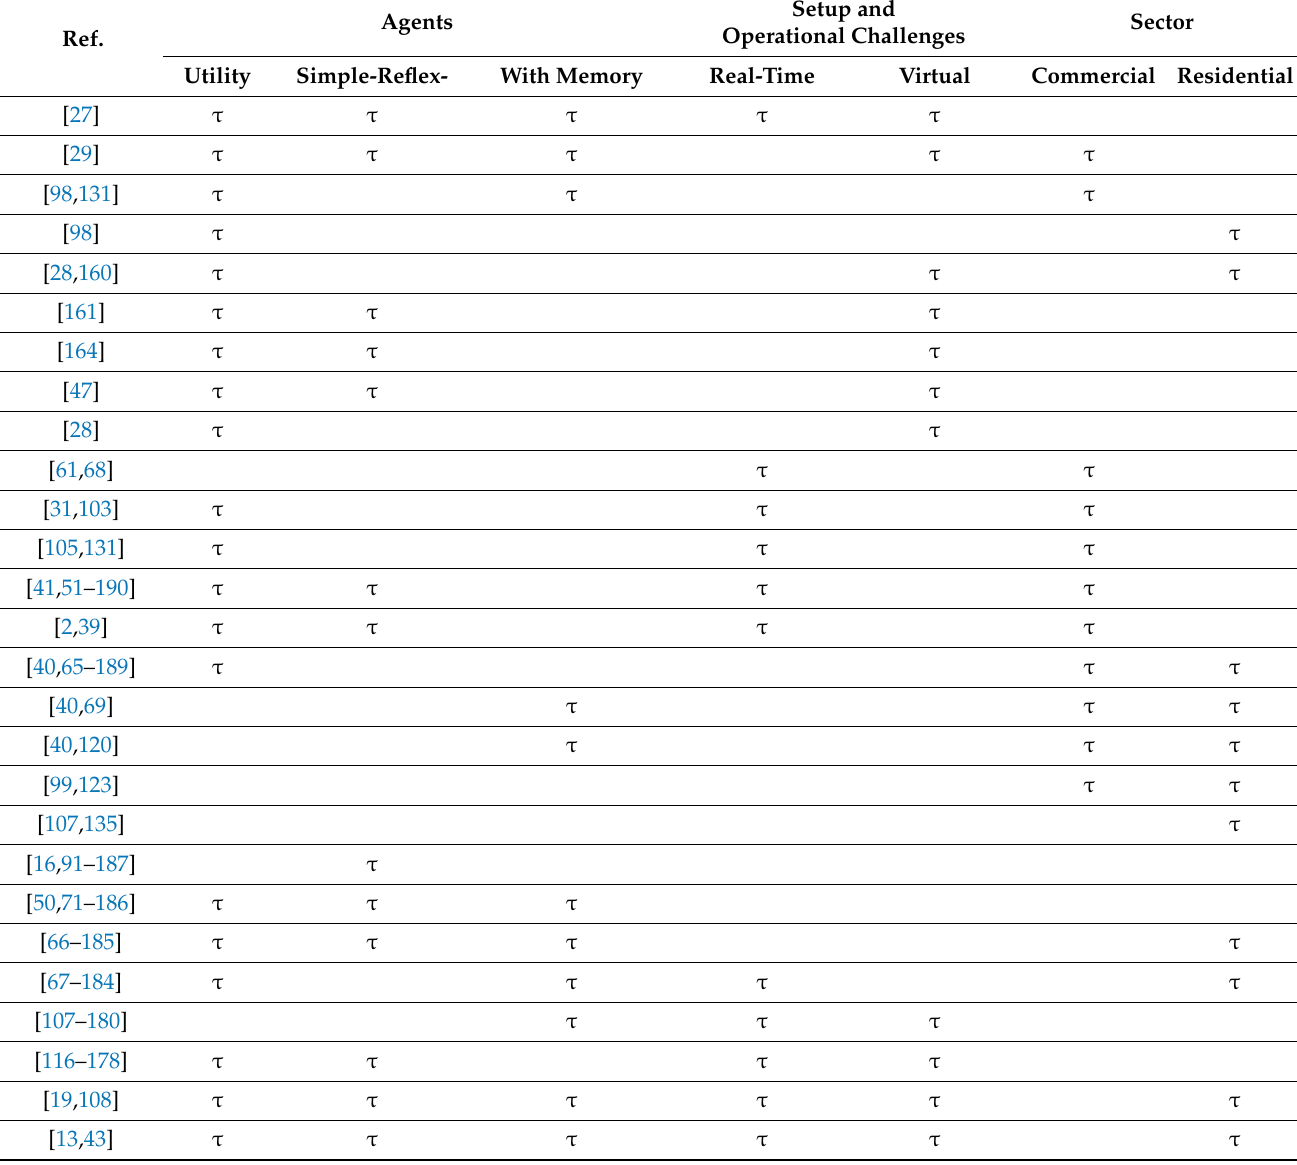
Table 6. Reported research and the MAS